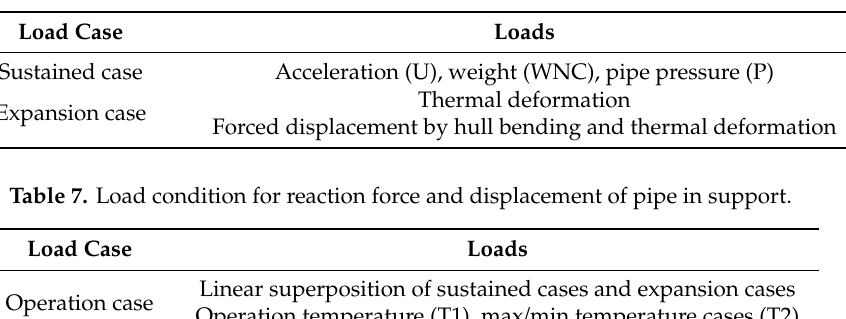
Table 6. Load conditions for stress assessment.